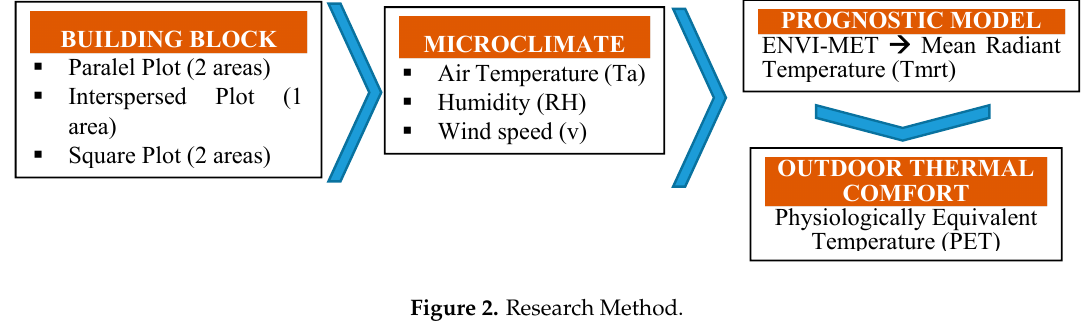
Figure 2. Research Method.